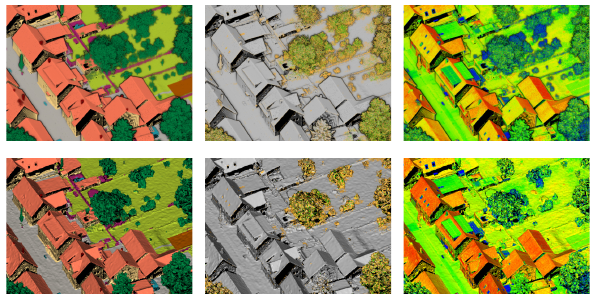
Figure 3. The top row shows the PC of H3D colored by manually assigned labels ( left ), number of returns ( center ), and reflectance values ( right ). The bottom row shows the counterparts on the mesh where all quantities have been automatically transferred from the PC deploying PCMA. Faces that cannot be linked with points are depicted in black . Please